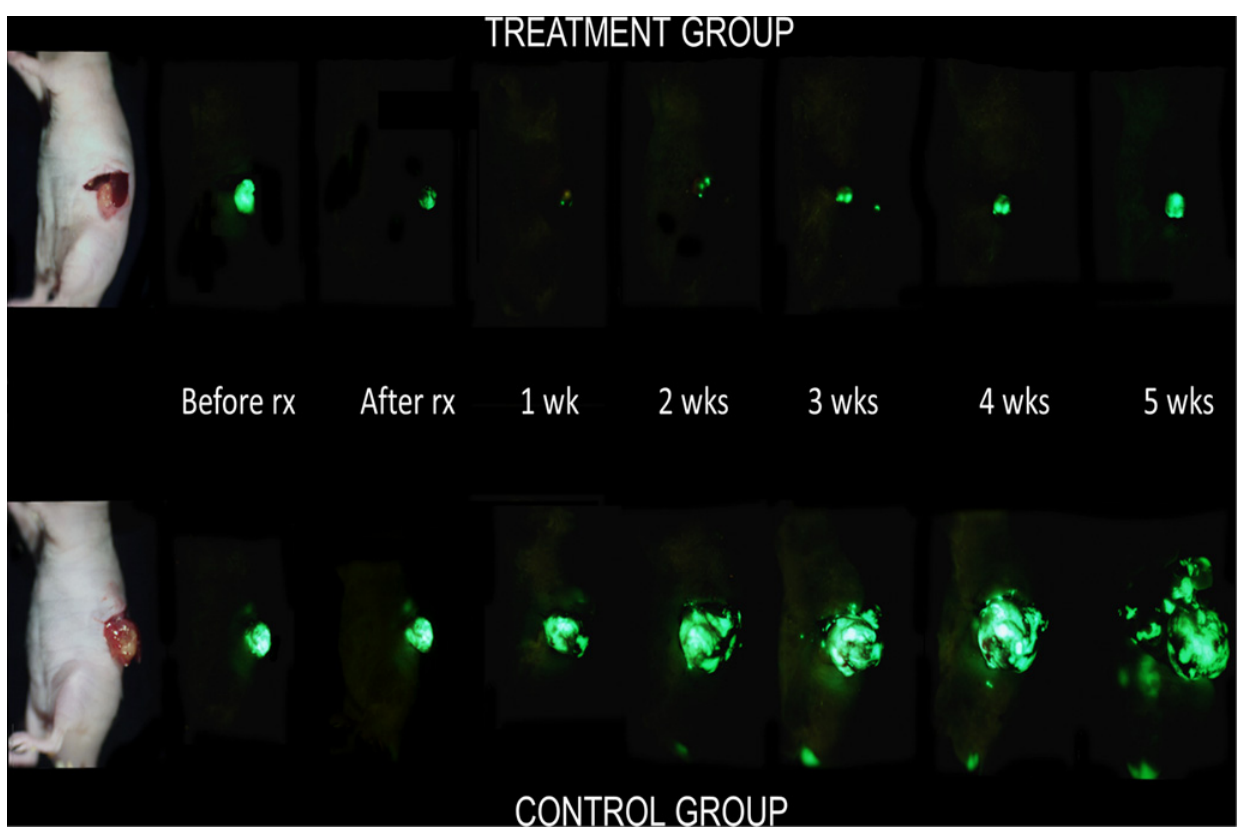
Fig 4. GFP weekly imaging of pancreatic tumors. Mice had their tumors exposed via a left lateral incision and imaged with the OV-100. Maximal effect of PIT was noted one week after initiation of therapy.